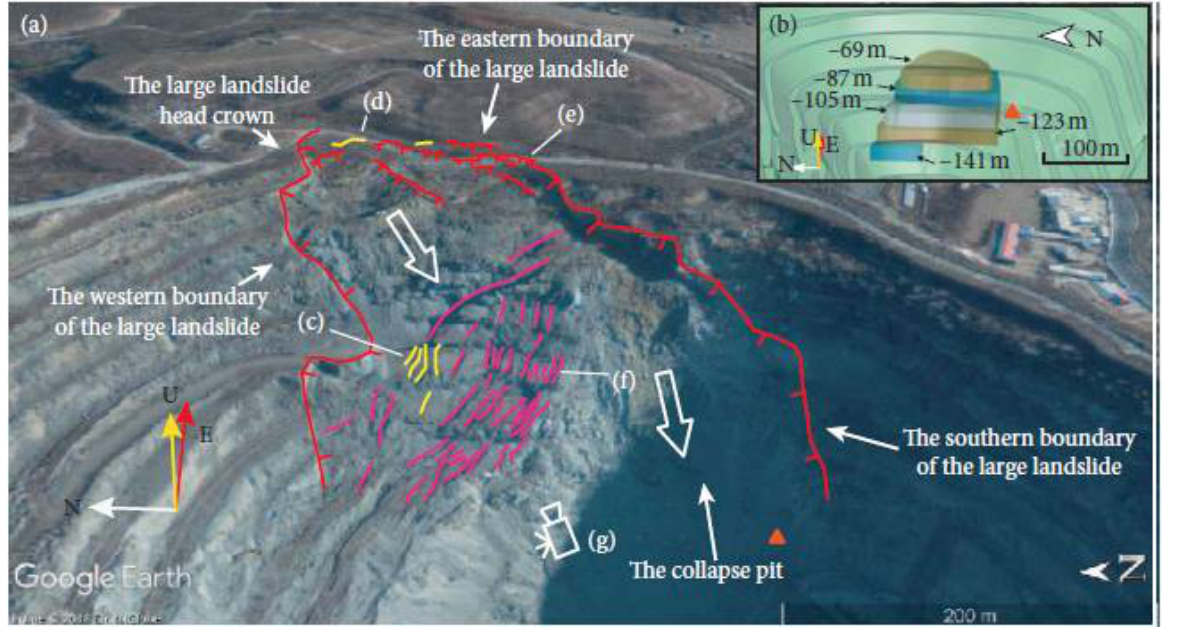
Figure 12. Image of collapsed phyllite materials in the northeastern slope (Adapted from [105]). ( a )cracks initiation point ( b )location of the mining area ( c )Tension cracks from the western bound- ( a ) cracks initiation point ( b ) location of the mining area ( c ) Tension cracks from the western boundary ary of the landslide ( d )Initial collapse area ( e ) Tension crack at the eastern boundary of the land- of the landslide ( d ) Initial collapse area ( e ) Tension crack at the eastern boundary of the landslide slide ( f ) Collapsed pits ( g )Google Earth monitoring technique ( f ) Collapsed pits ( g ) Google Earth monitoring technique.